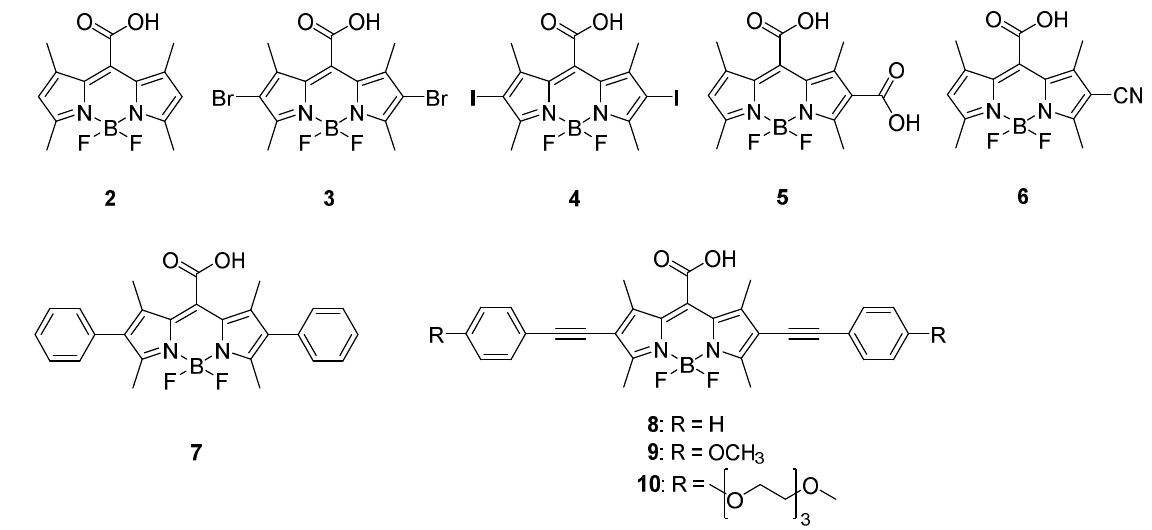
Figure 1. meso -Carboxy BODIPY derivatives 2 – 10 studied in this work.